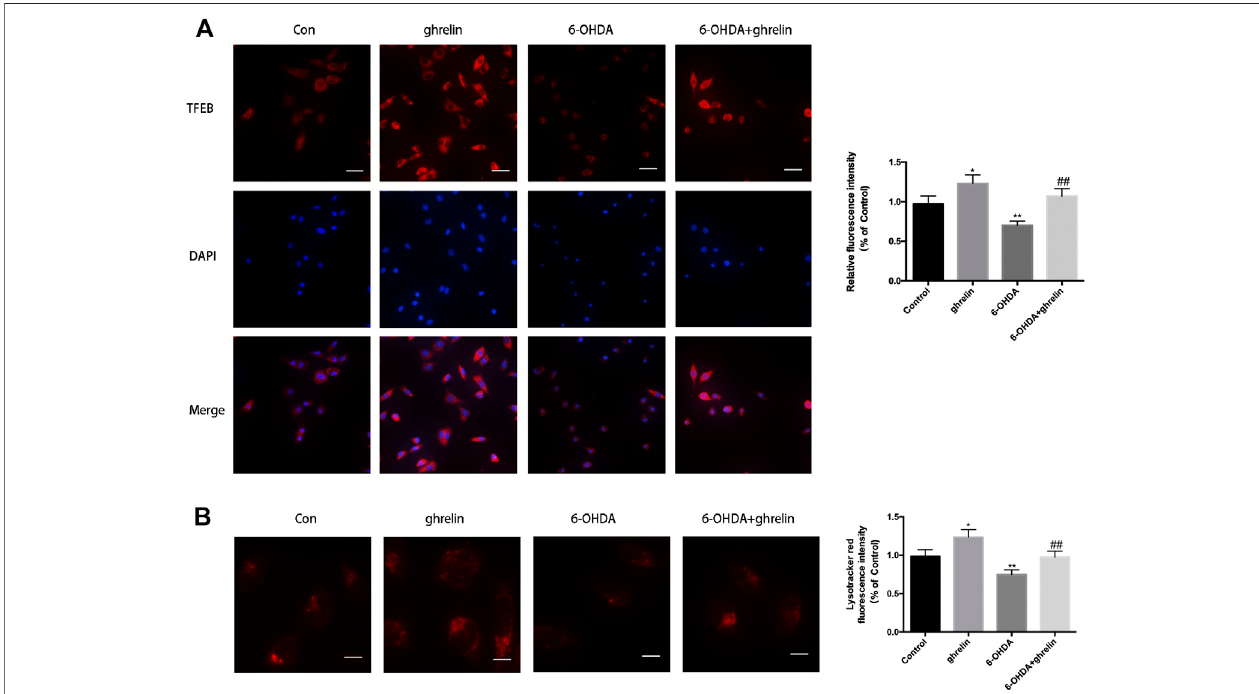
FIGURE5| GhrelinpreserveslysosomesandTFEBexpressionagainst6-OHDA-inducedneurotoxicity. (A) Representativeimmuno fl uorescencestainingforTFEB inSH-SY5Ycellstreatedwithghrelin,6-OHDAorghrelinand6-OHDAfor24 h,scalebar (cid:2) 50 μ m. (B) Representativelysotrackerstainingandquanti fi cationofSH-SY5Y cells treated with ghrelin, 6-OHDA or ghrelin and 6-OHDA for 24 h, scale bar (cid:2) 10 μ m. Data are presented as mean ± SD; * p < 0.05 vs. the control group, ** p < 0.01 vs. the control group, ## p < 0.01 vs. the 6-OHDA group, n (cid:2) 5.